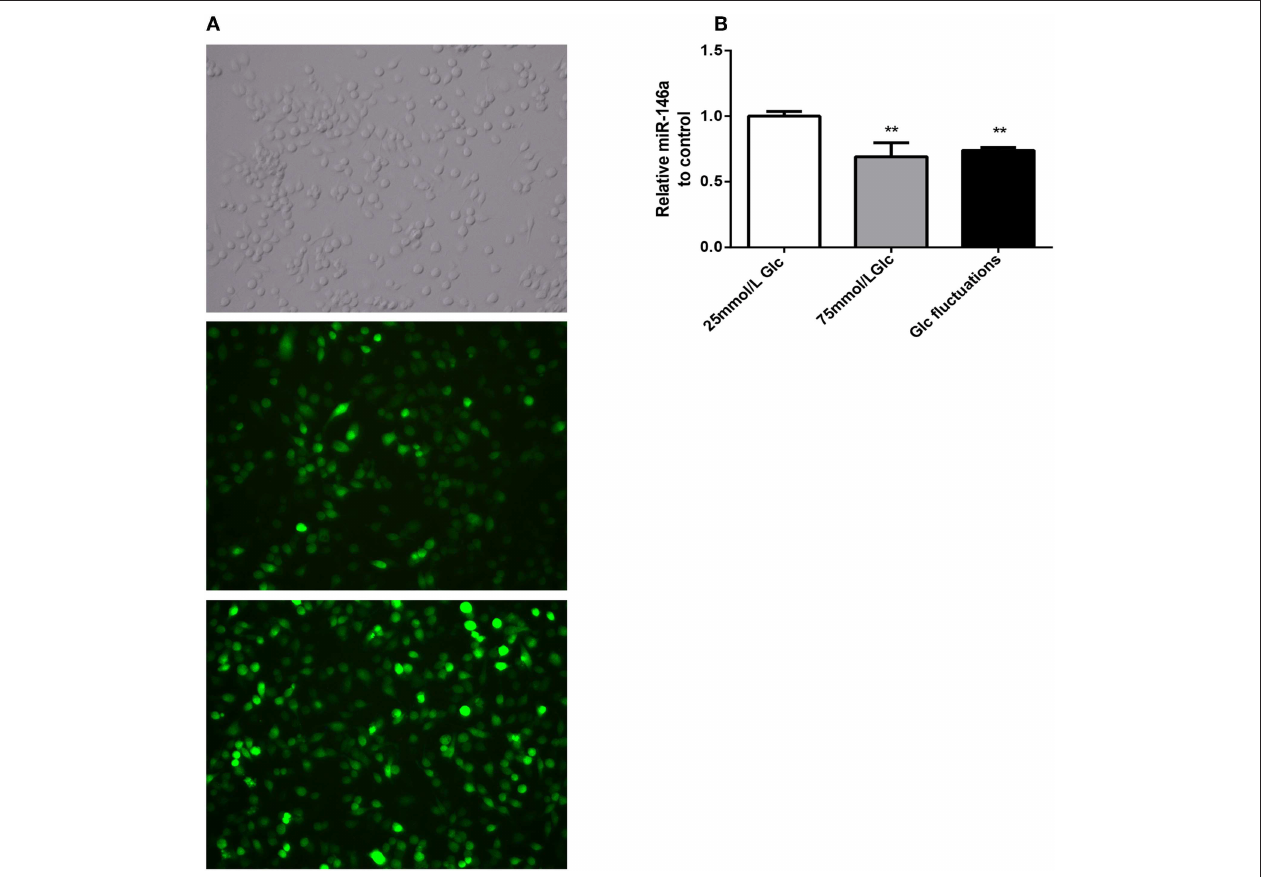
FIGURE 2 | GFP expression and miR-146a expression levels after lentiviral infection in BV-2. (A) GFP expression after BV-2 transfection with over-expression of miR-146a lentivirus and control virus. (B) miR-146a expression levels before and after BV-2 transfection with over-expression of miR-146a lentivirus, *** p < 0.001 Lv-mmu-miR-146a group vs.